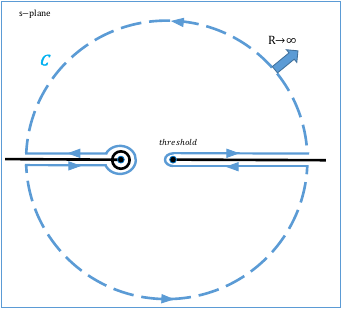
Figure 5. Typical contour of integration to apply Cauchy’s Theorem and obtain a Dispersion Relation. The curved part of the contour is taken to ∞ and vanishes if the integrand tends to zero su ffi ciently fast, leaving only the integrals surrounding the cuts. Since amplitudes in the lower plane are the conjugate of their values in the upper one, the integrands can be rewritten in terms of imaginary parts of the amplitudes only, leading to Eq.(1). Figure taken from